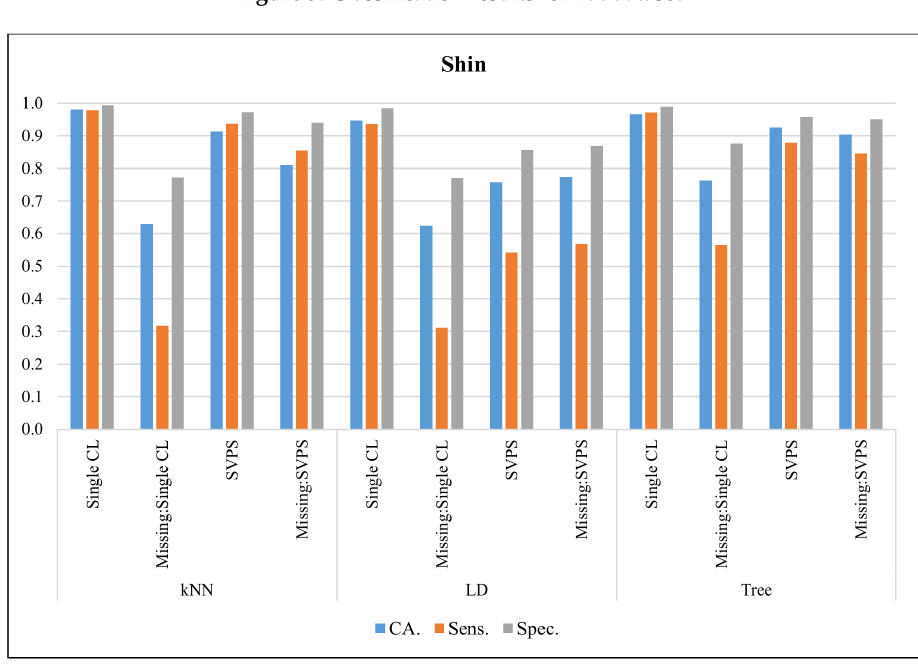
Figure 5. Classification results for Fat dataset.